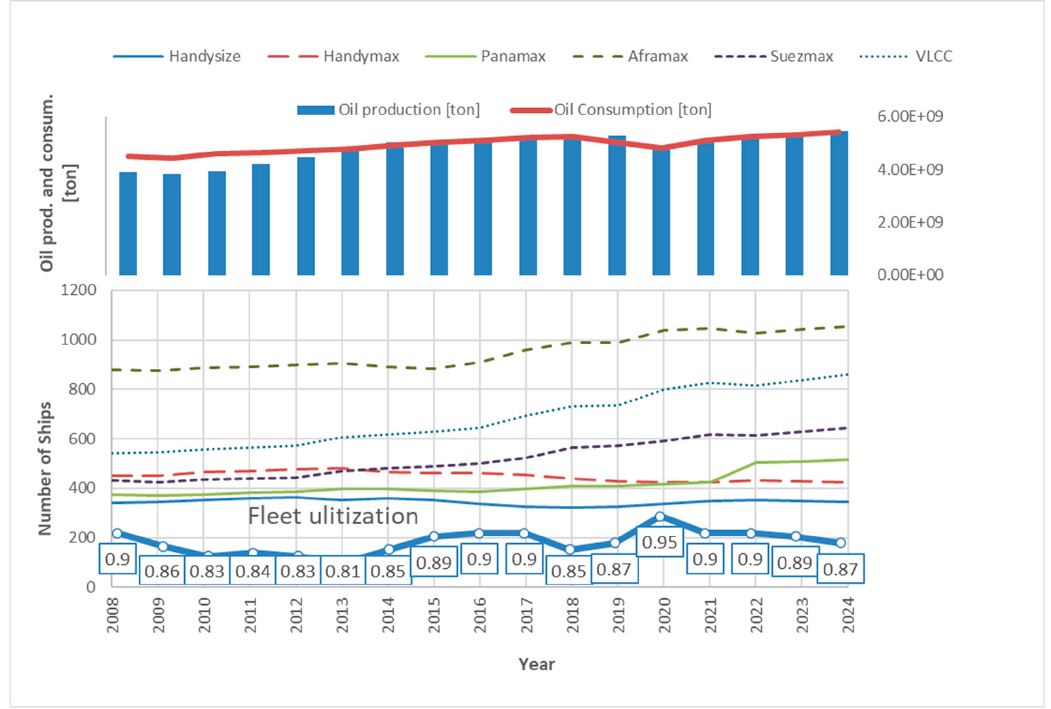
Figure 1. Oil production and consumption review.